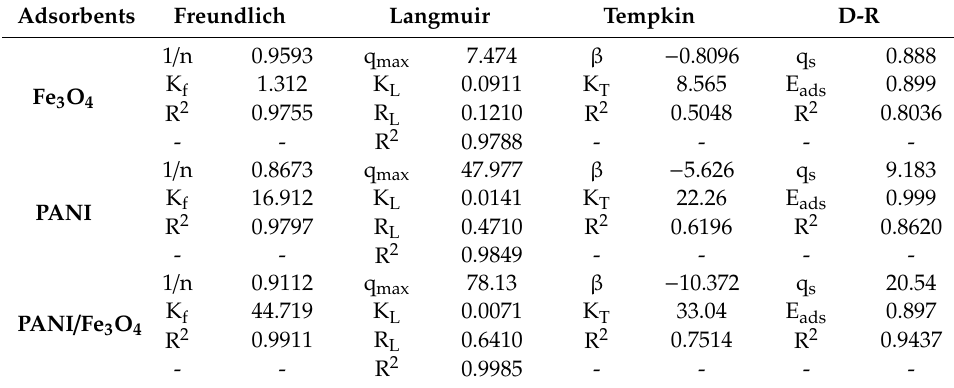
Table 2. Parameters calculated from adsorption isotherm models applied for adsorption of BB3 on Fe 3 O 4 , PANI, and PANI / Fe 3 O 4 composites. Adsorbents